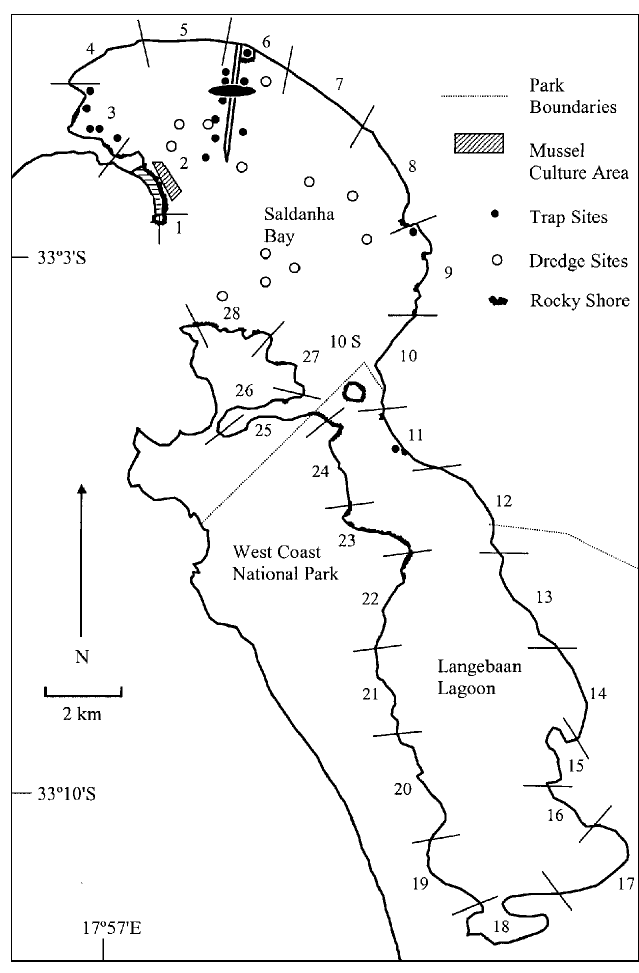
Fig. 1. Map of Saldanha Bay and Langebaan Lagoon, showing the bound- aries of the West Coast National Park and the 28 areas which were